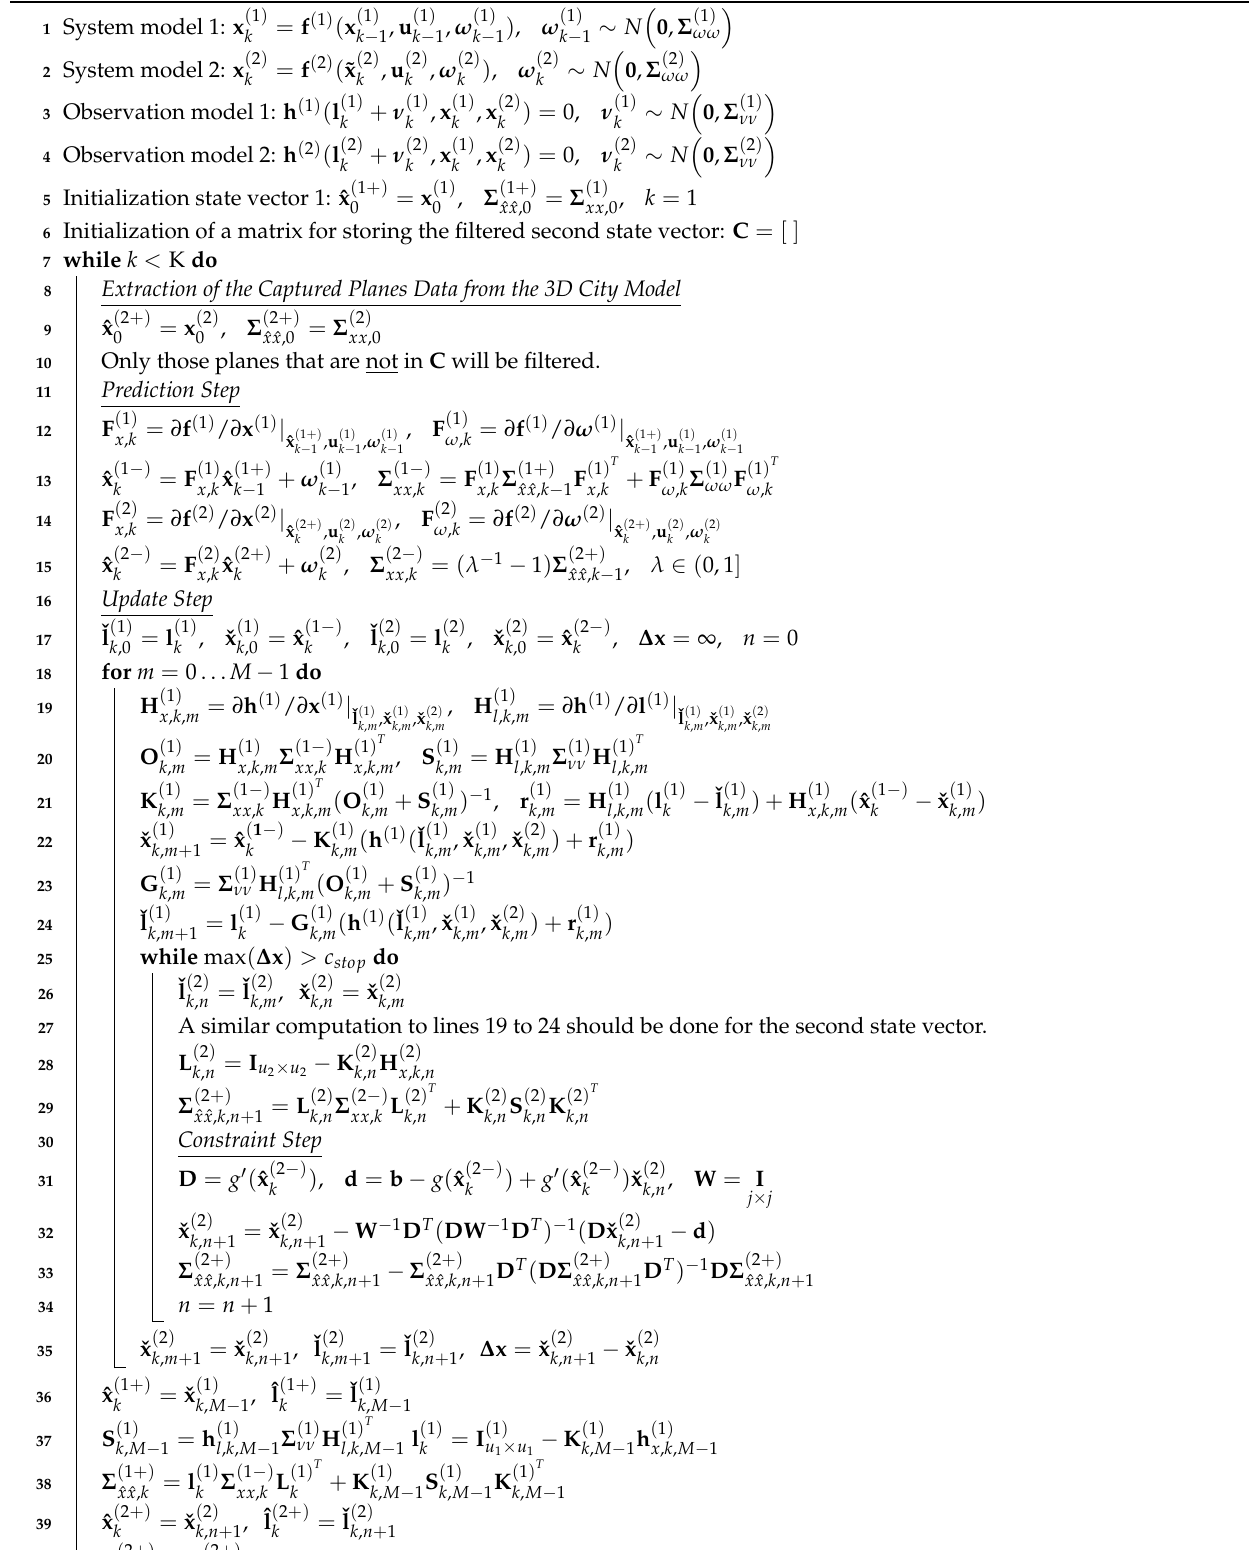
Algorithm 1: Dual State Iterated Extended Kalman Filter (DSIEKF) with nonlinear equality